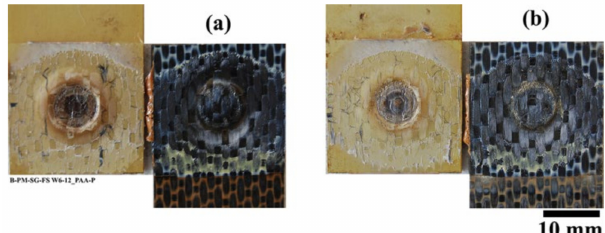
Figure 20. Fracture surface of the PAA-P pre-treated joints after ( a ) six months and ( b ) 12 months of outdoor